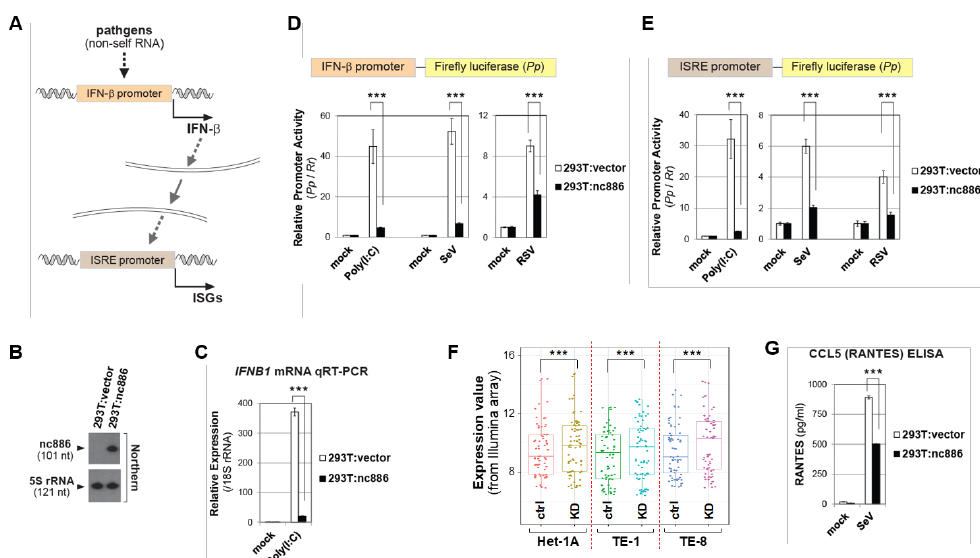
Figure 1. nc886 suppresses the IFN- β signaling. ( A ) Image showing the IFN- β signaling leading to ISG expression. See the text for details. ( B ) Northern hybridization of nc886 and 5S rRNA as a loading control in indicated cell lines. ( C ) qRT-PCR measurement of IFN- β mRNA (from the IFNB1 gene) at 8 h after Poly (I:C) transfection. y -axis: 2 - ∆∆ Ct values normalized to 18S rRNA and relative to the value of mock transfected 293T:vector being set as 1. ( D ) Luciferase assays for the firefly ( Pp ) plasmid depicted above, upon experimental treatments indicated in the figure caption. A Pp value was normalized to the Renilla ( Rr ) luciferase value from co-transfected pRL-SV40. For each treatment, a Pp / Rr value relative to the corresponding “mock” value was plotted ( y -axis). An average, a standard deviation, and a p -value were calculated from pentaplicate samples. Initial transfection of luciferase plasmids (time at 0 h); Poly(I:C)-LMW transfection or viral infection at 9 h; luciferase assays at 24 h. RSV and Sendai was infected at one multiplicity of infection (MOI). ( E ) ISRE luciferase assays. All the descriptions are the same as panel D, except for Poly(I:C)-LMW transfection and viral infection at 15 h. ( F ). Expression of selected ISGs upon nc886 KD (by an anti-oligo targeting nc886; designated as “KD”) and control KD (by a non-targeting oligo; “ctrl”). Details about KD experiments are in the reference [7]. Expression values ( y -axis) are Illumina array values of 23 genes that were significantly altered in nine experimental sets (three cell lines, triplicates each). Paired t-test was used to calculate p -values between “ctrl” and “KD”. ( G) . RANTES ELISA from the culture supernatant at 24 h after SeV infection. Three asterisks designate a p -value less than 0.001,